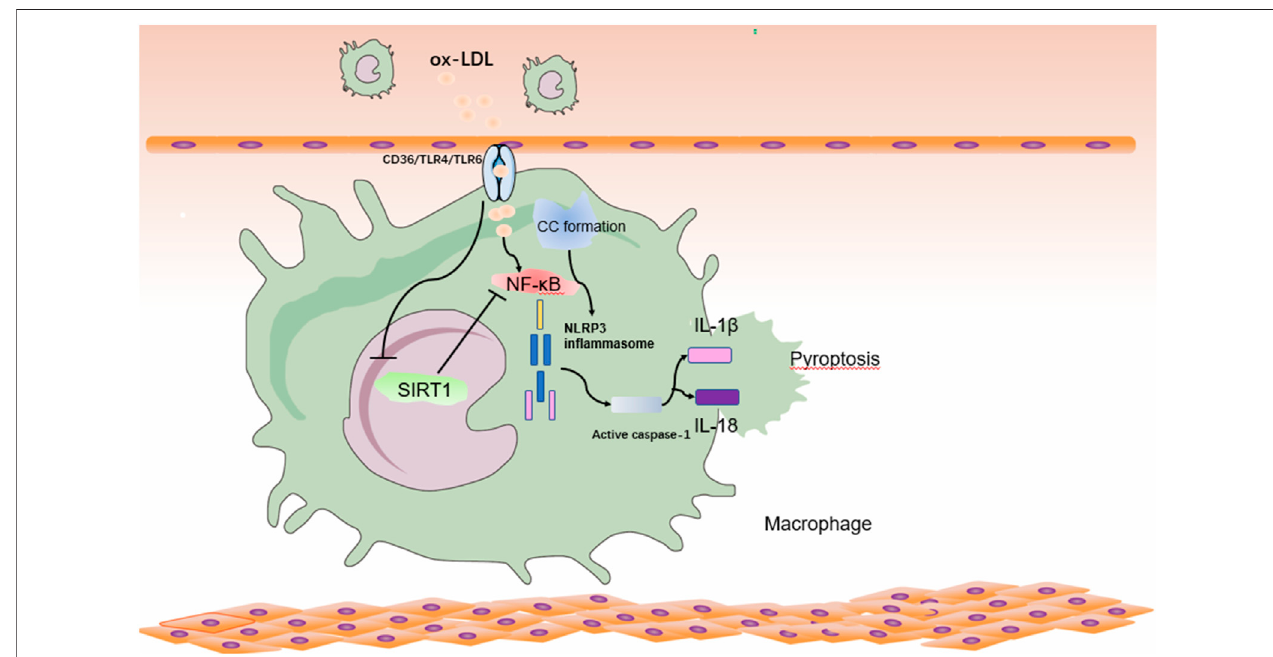
FIGURE2| RelationshipbetweenSIRT1andpyroptosispathwayinatherosclerosisinmacrophages.Ox-LDLandCC-inatheroscleroticlesionsactivatesNF- κβ in macrophages with NLRP3 in fl ammatory vesicle initiation and NLRP3 in fl ammatory vesicle activation, promoting the in fl ammatory factor IL-18/IL-1 β , leading to cytoplasmicswellingandmembranerupture,resultinginthereleaseofin fl ammatoryfactorsandpromotingtheonsetofpyroptosis.Atthesametime,ox-LDLinhibitsthe expressionofSIRT1,whichfurtherleadstotheactivationofNF- κβ ,andthisviciouscirclewillfurtheraggravatethedevelopmentofAS.ox-LDL:oxidativelymodi fi